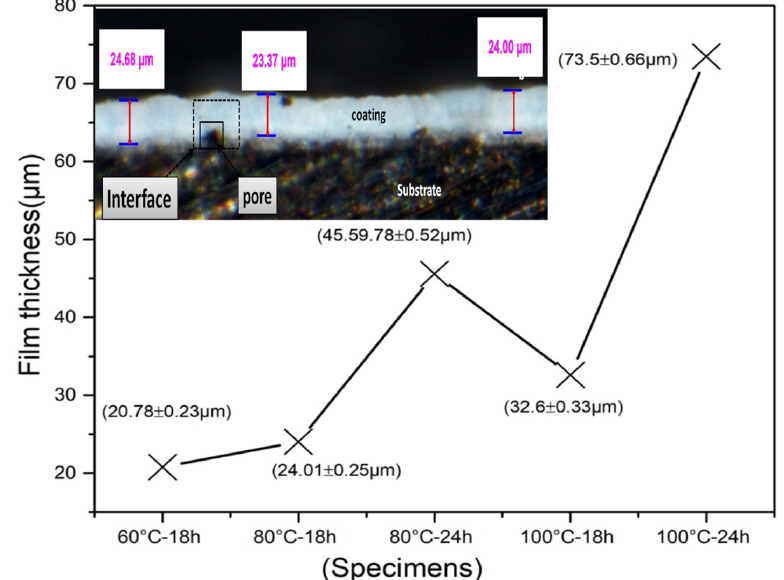
Figure 5. MgAl LDH thickness of the film coated AA6082 estimated from the cross-sectional optical microscopic images as a function of reaction temperature and treatment time, (for representation, insight is the optical images of LDH at 80 ◦ C and 18 h reaction